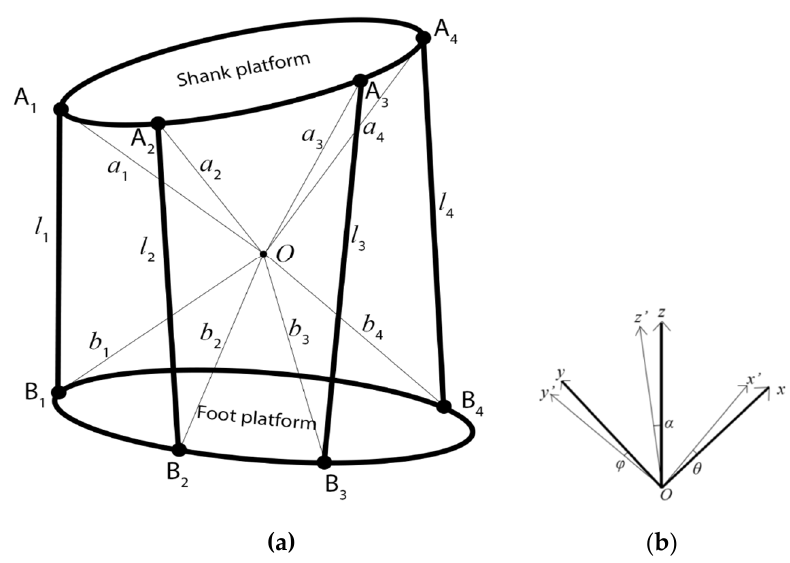
Figure 3. ( a ) Kinematic scheme with motion variables and ( b ) reference frames.